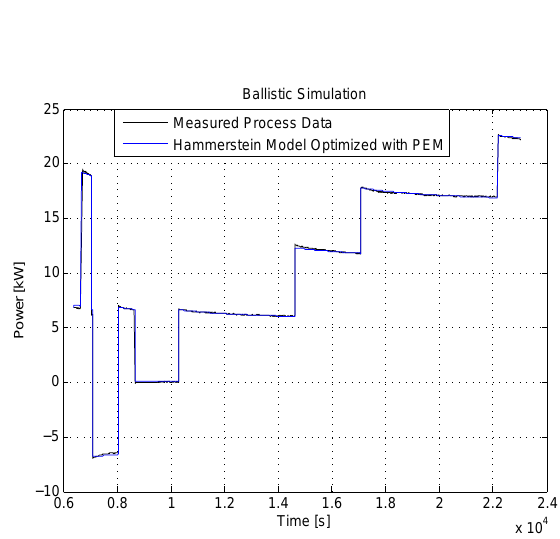
Figure 15: Ballistic simulation of the final Hammer- stein model.